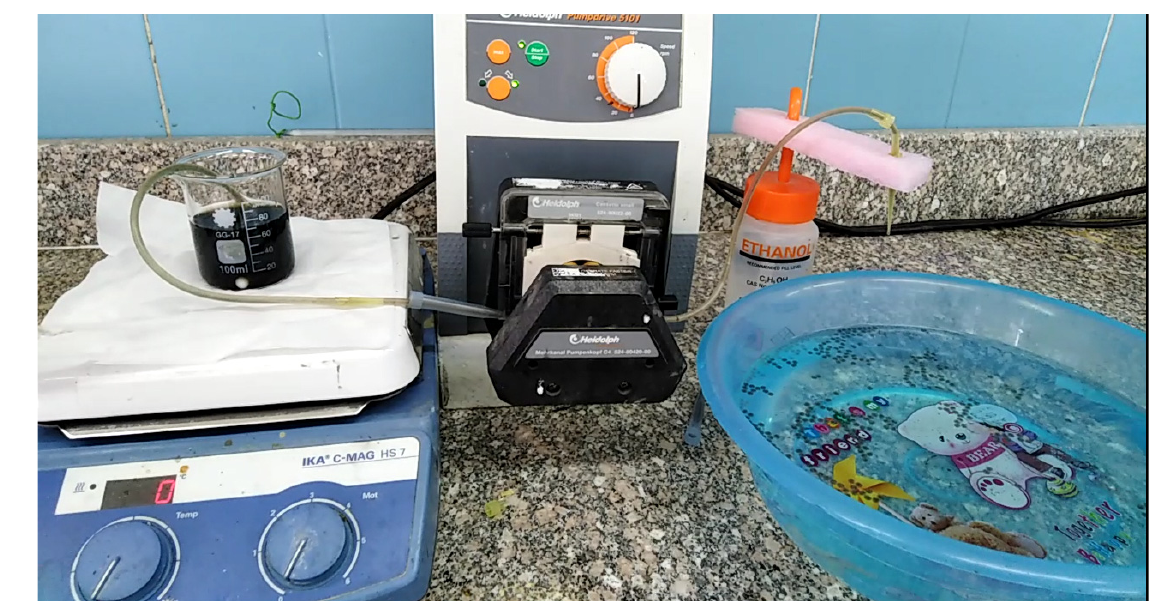
Figure 1. Photographic images of the continuous system used to prepare GO@CS beads.